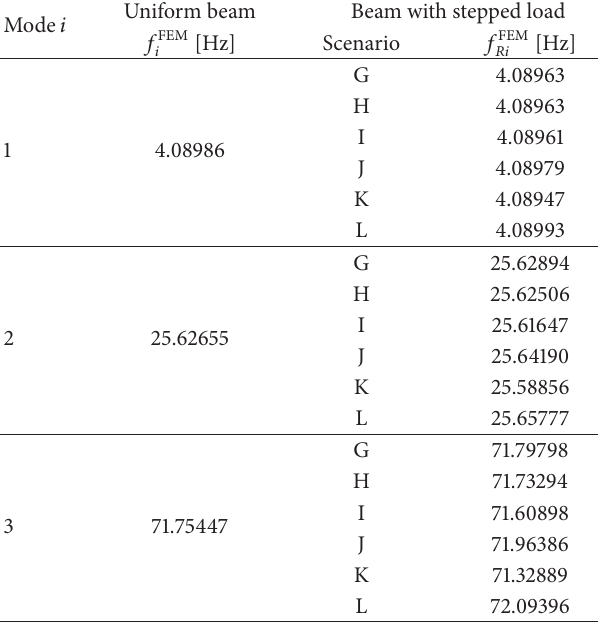
Table 4: Natural frequencies analytically derived for concentrated mass loads.